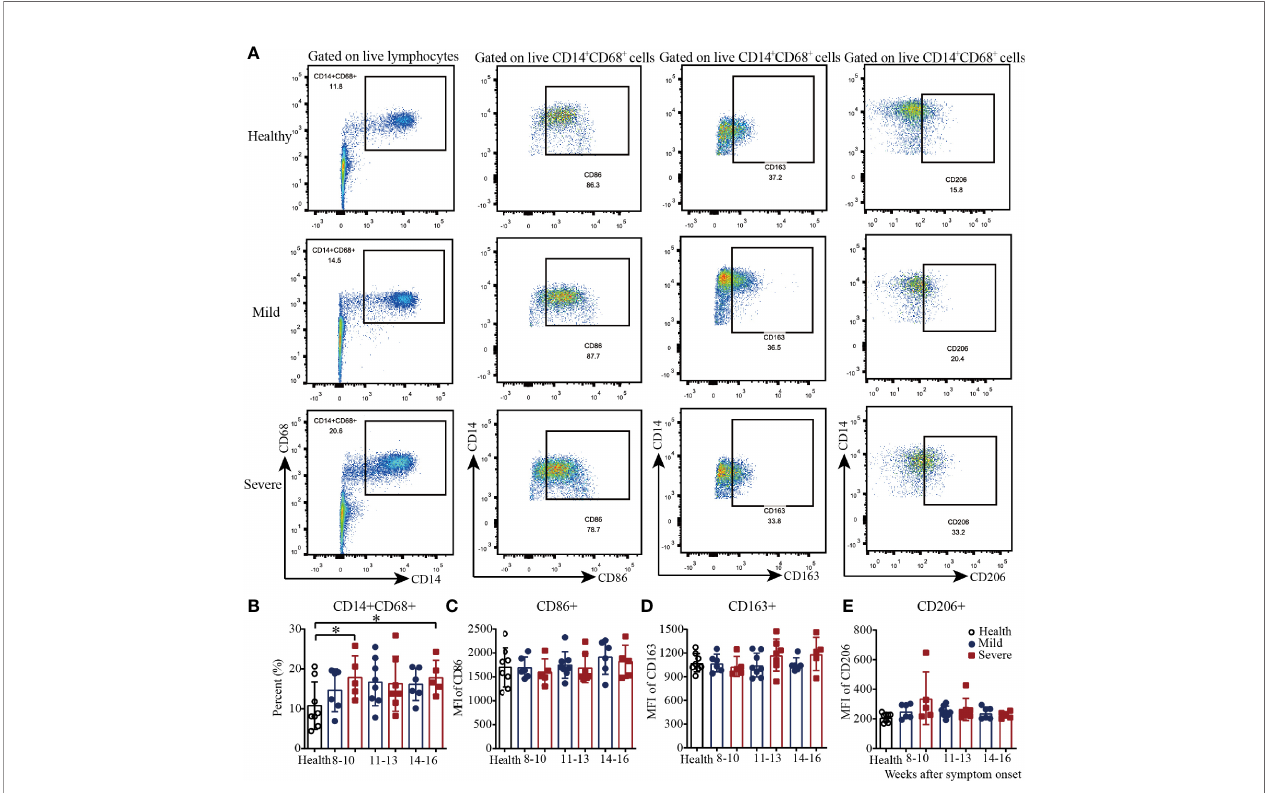
FIGURE 2 | Phenotypic analysis of macrophages in PBMCs from recovered COVID-19 patients. Representative fl ow cytometry plots showing the expression patterns of different macrophage subsets in recovered COVID-19 patients (A) . Comparison of the frequencies of CD14 + CD68 + (B) , CD86 + (C) , CD163 + (D) , and CD206 + (E) macrophages between the mild and severe patients from 8 to 16 weeks after symptom onset (Health, n=8; patient, n=22).